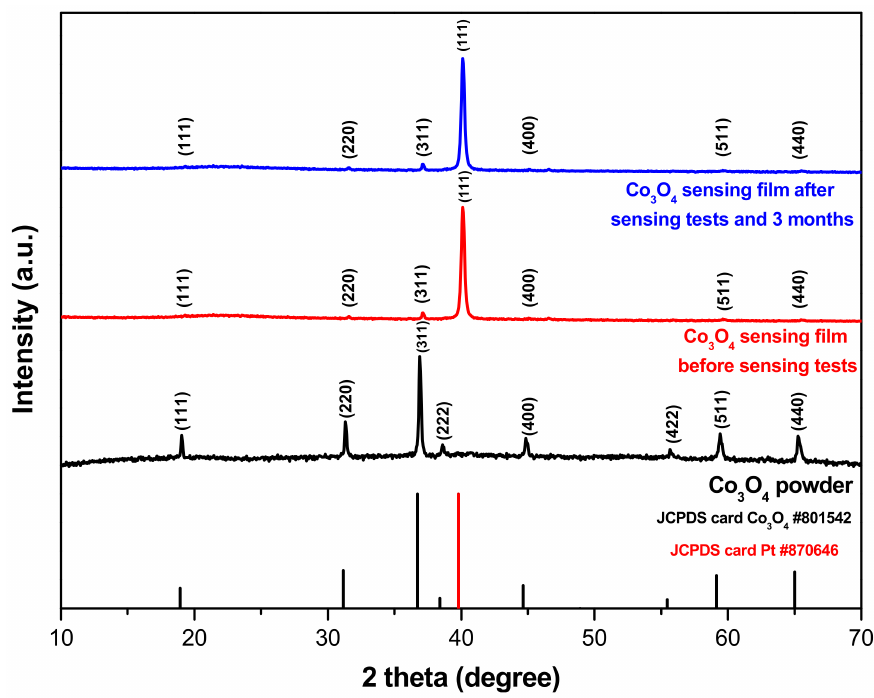
Figure 3. X-ray diffraction pattern of Co 3 O 4 nanoparticles and sensing element after thermal anneal- ing, before and after sensing tests and 3-month